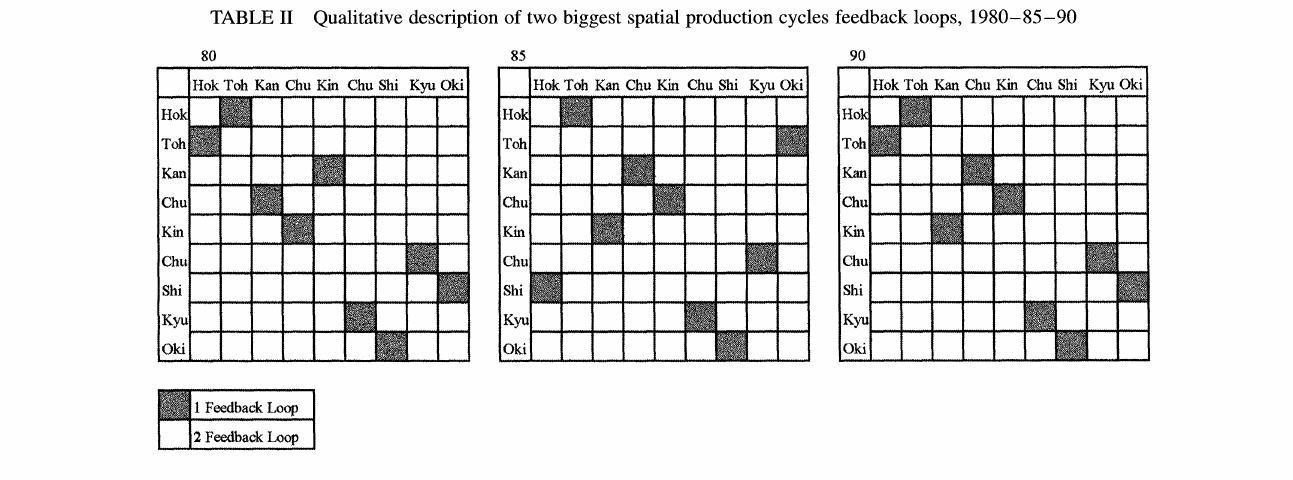
TABLE II Qualitative description of two biggest spatial production cycles feedback loops, 1980-85-90